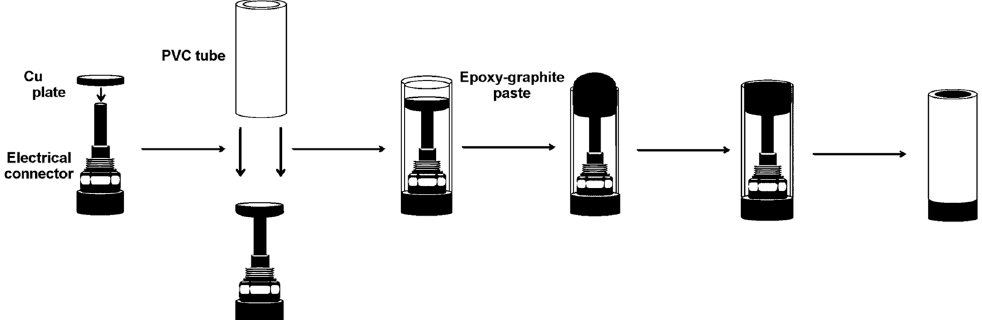
Figure 1. Construction of working electrodes based on graphite-epoxy composite.